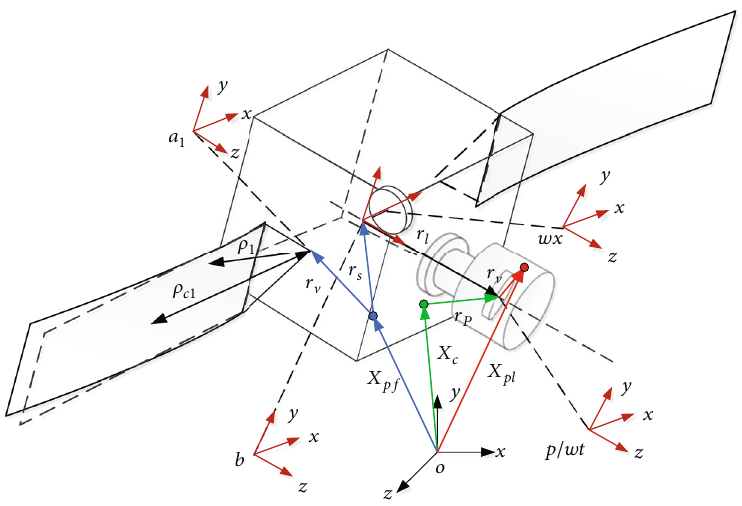
Figure 3: Coordinate frames and vectors used for